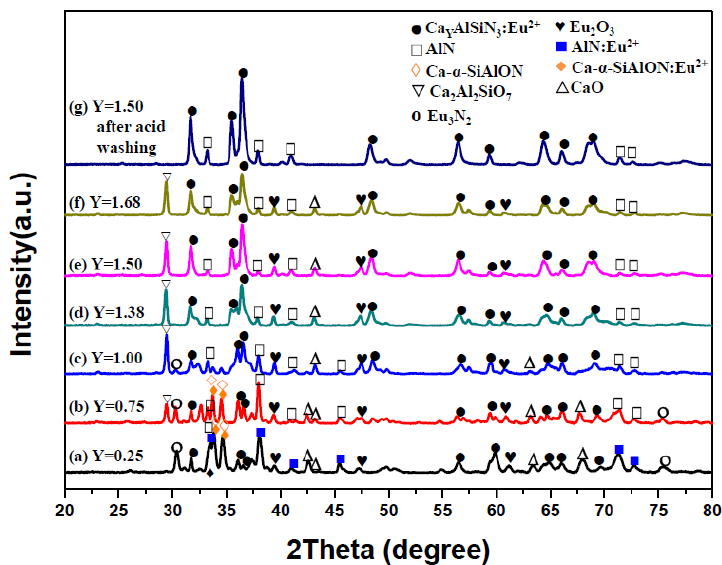
Figure 1. XRD patterns of the as-synthesized products obtained with Y = 0.25 ( a ); 0.75 ( b ); 1.00 ( c ); 1.38 ( d ); 1.50 ( e ); and 1.68 ( f ); and a product obtained with Y = 1.50 after acid washing ( g ).